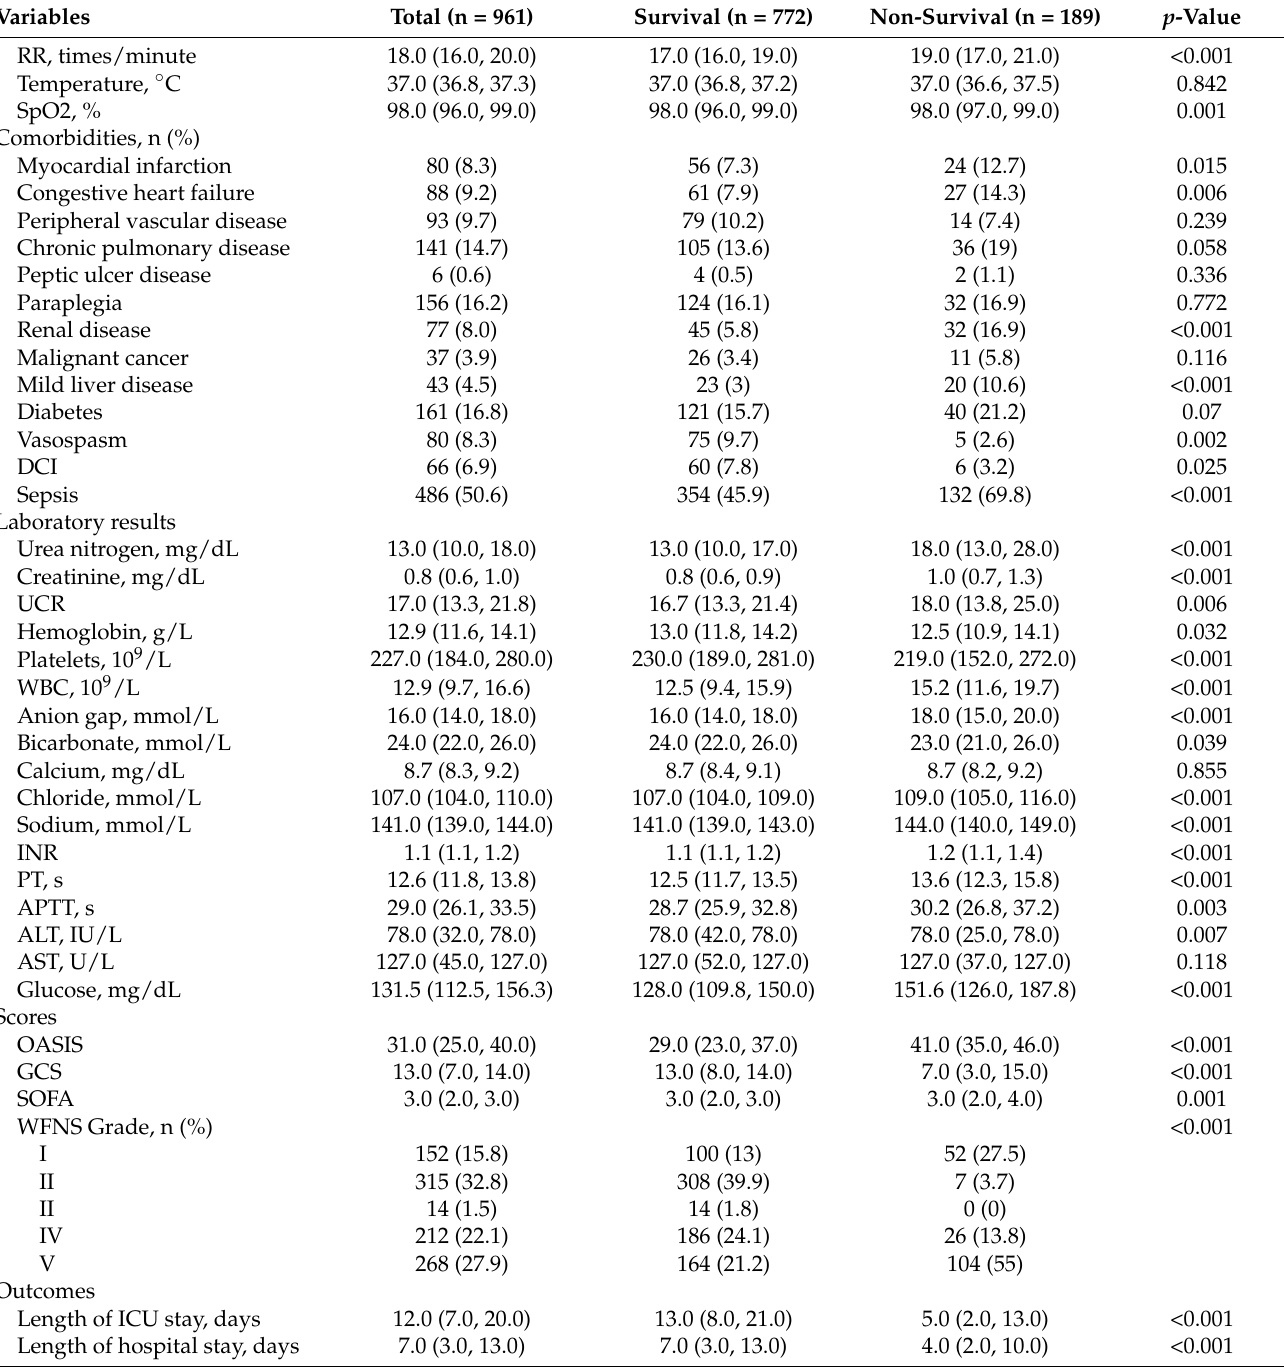
the highest Youden index to predict the survival status, where the Youden index = sensitivity + specificity − 1. The corresponding optimal cut-off value was 27.208, the